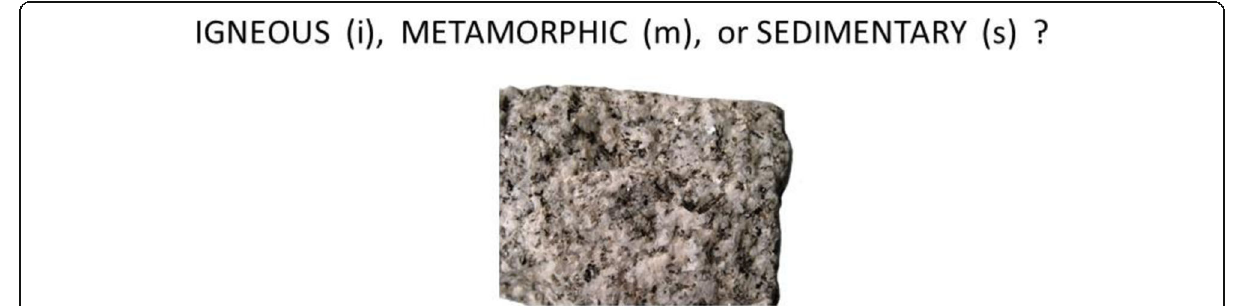
Fig. 2 Schematic example of a trial from the training and test phases of condition 1 and the test phase of condition 3